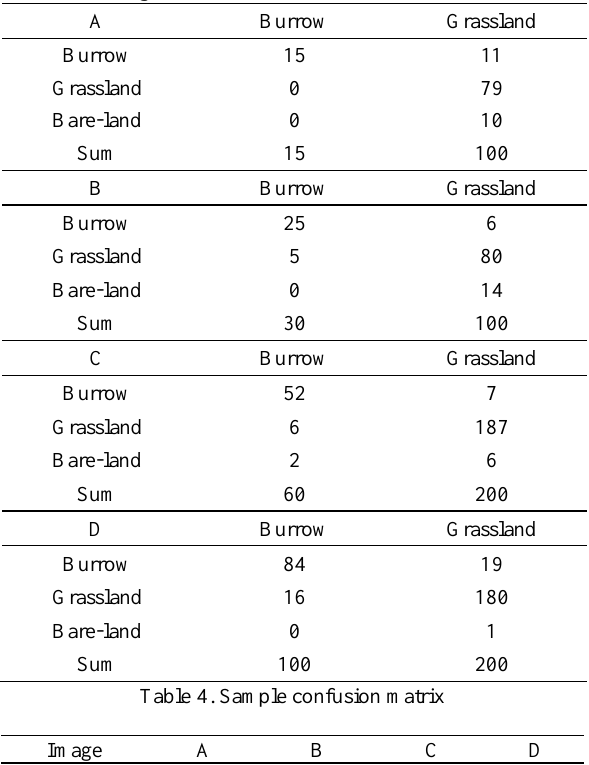
Figure 5. Burrow classification results